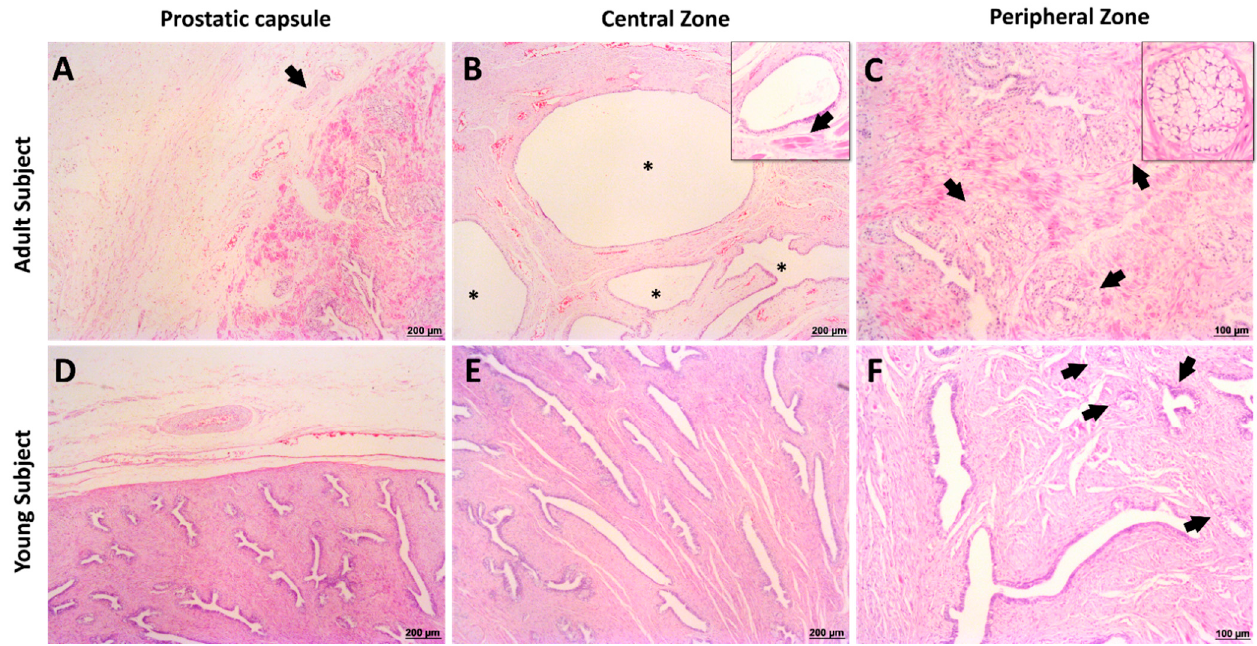
Figure 4. Histological evaluation of giant anteater prostate gland. ( A ): peripheral region of the prostate gland capsule of an adult subject presenting the peripheral nerves (arrow) and blood vessels. ( B ): central zone of the adult giant anteater, presenting prostatic ducts (insert) with large lumen (asterisk). ( C ): peripheral zone showing a central duct surrounded by secretory cells (insert). It is observed a high density of luminal secretory cells (arrows). ( D ): peripheral region of a young giant anteater capsule showing large caliber blood vessels. ( E ): central zone of a young giant anteater enriched by ducts with columnar epithelium. ( F ): peripheral zone of a young giant anteater prostate gland present high caliber ducts and small cluster with secretory cells (arrows). Hematoxylin and eosin staining.